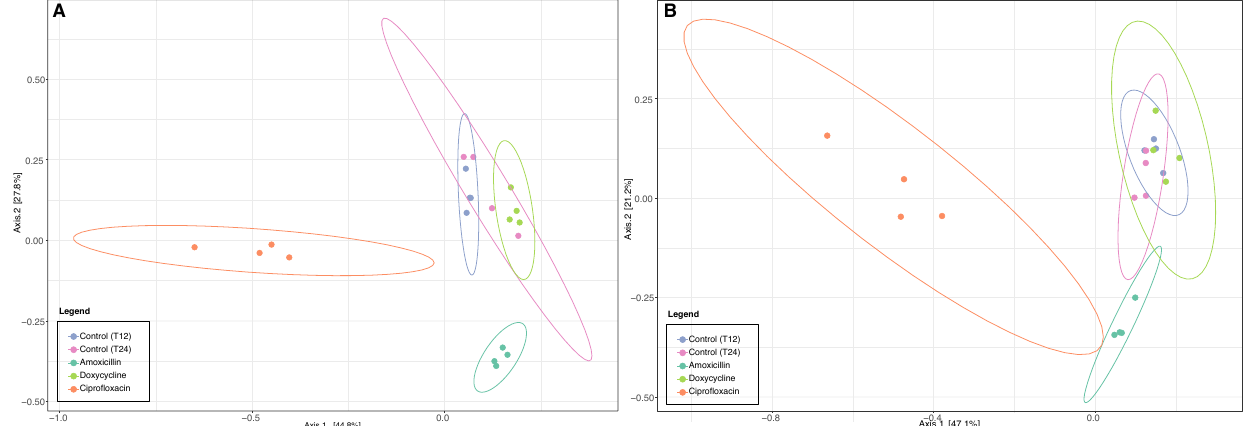
Figure 2. PCoAs showing the distribution of samples according on the presence and amount of ARGs ( A ) and ISs ( B ) in the samples. Samples are colored according to the antibiotics used (control, amoxicillin, ciprofloxacin, and doxycycline). The ellipses represent a 95% confidence interval. A correlation analysis between ISs and ARGs that included all the samples showed that there were significant correlations ( p < 0.01) distributed in six groups (Figure 3).